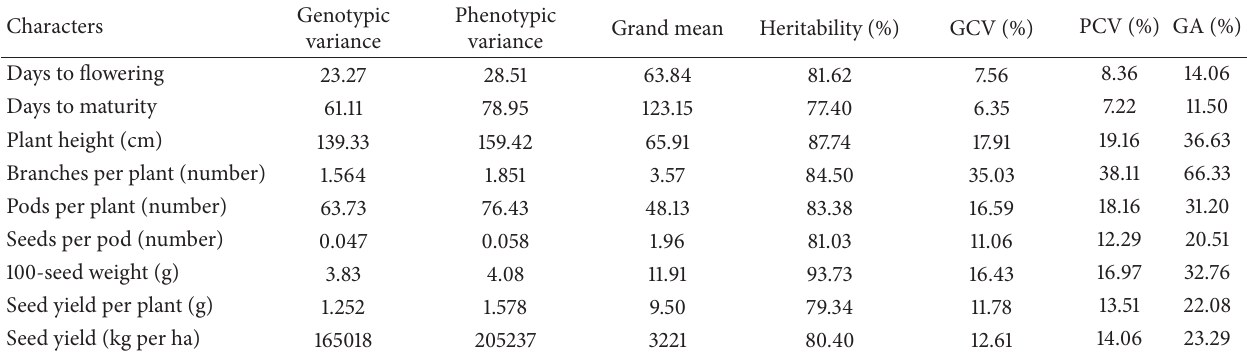
Table 4: Estimation of genetic parameters of nine different phenological and morphological characters, yield attributes, and seed yield among 31 soybean